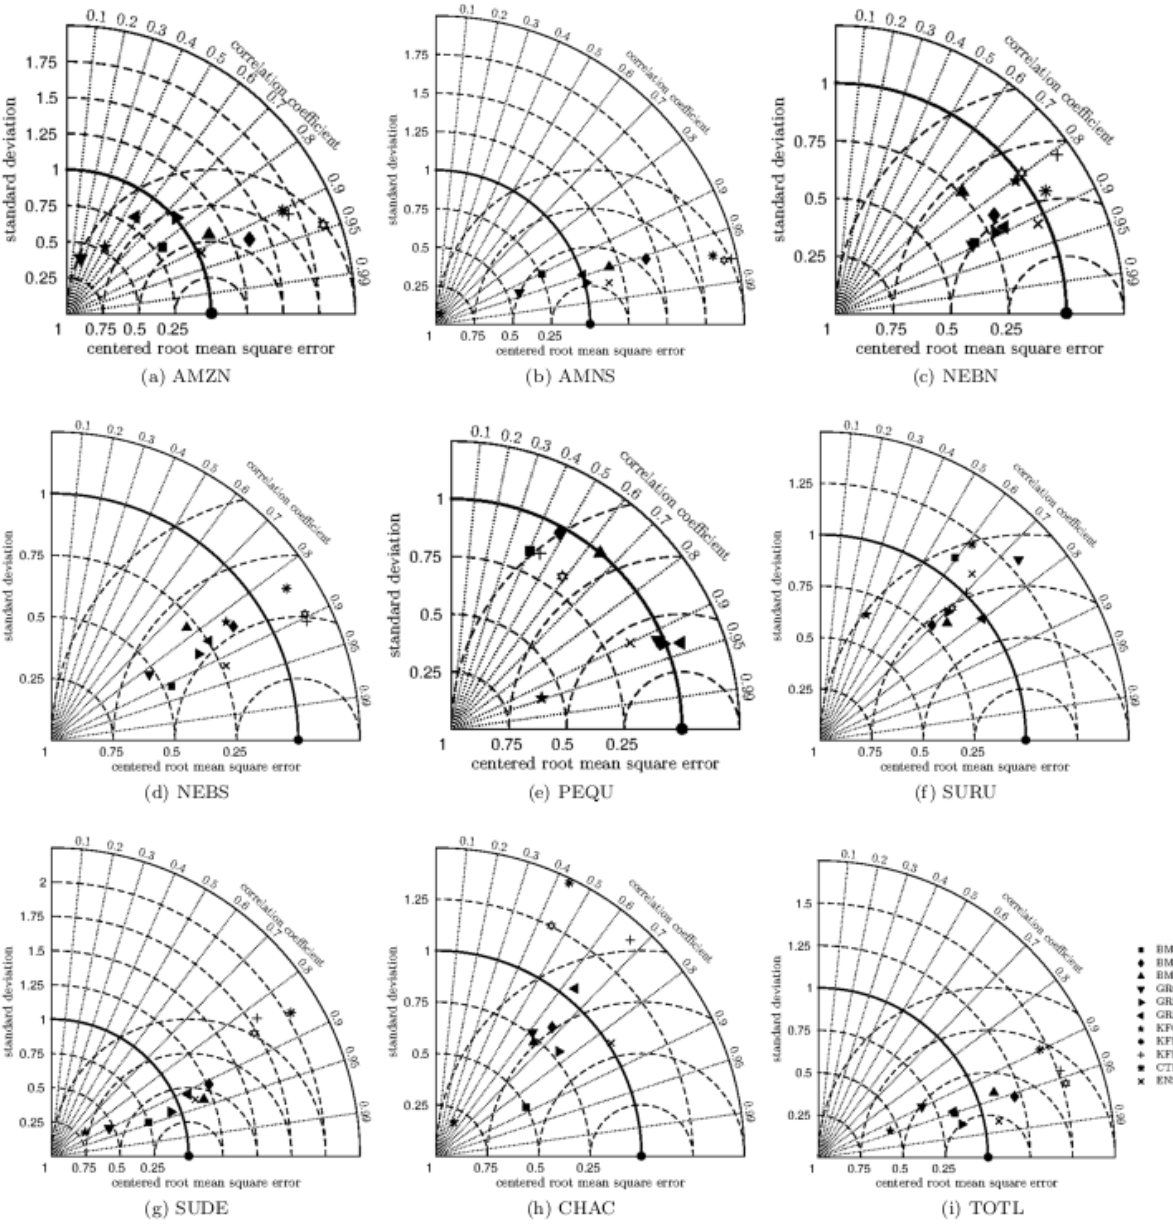
Figure 12. Taylor diagrams for area-averaged monthly precipitation in regions ( a ) AMZN, ( b ) AMZS, ( c ) NEBN, ( d ) NEBS, ( e ) PEQU, ( f ) SURU, ( g ) SUDE, ( h ) CHAC, and ( i ) TOTL shown in Figure 1. The reference (TRMM) data are shown by the closed circle along the horizontal axis. The individual experiments are shown by different